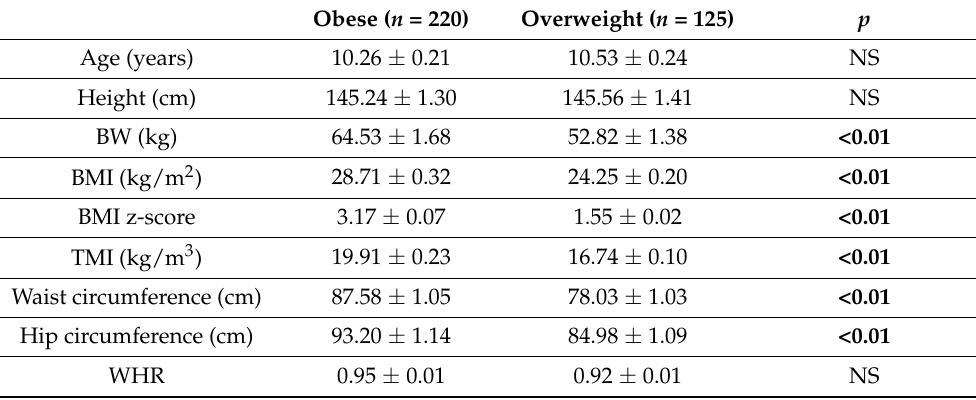
Table 2. Clinical characteristics of all subjects at initial